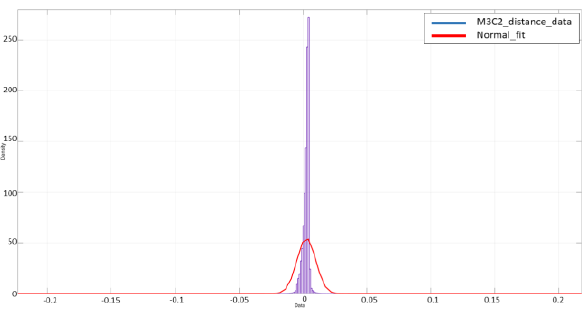
Figure 7. TLS-SLR comparison: histograms of all the M3C2 distance values and their normal distribution fitting.